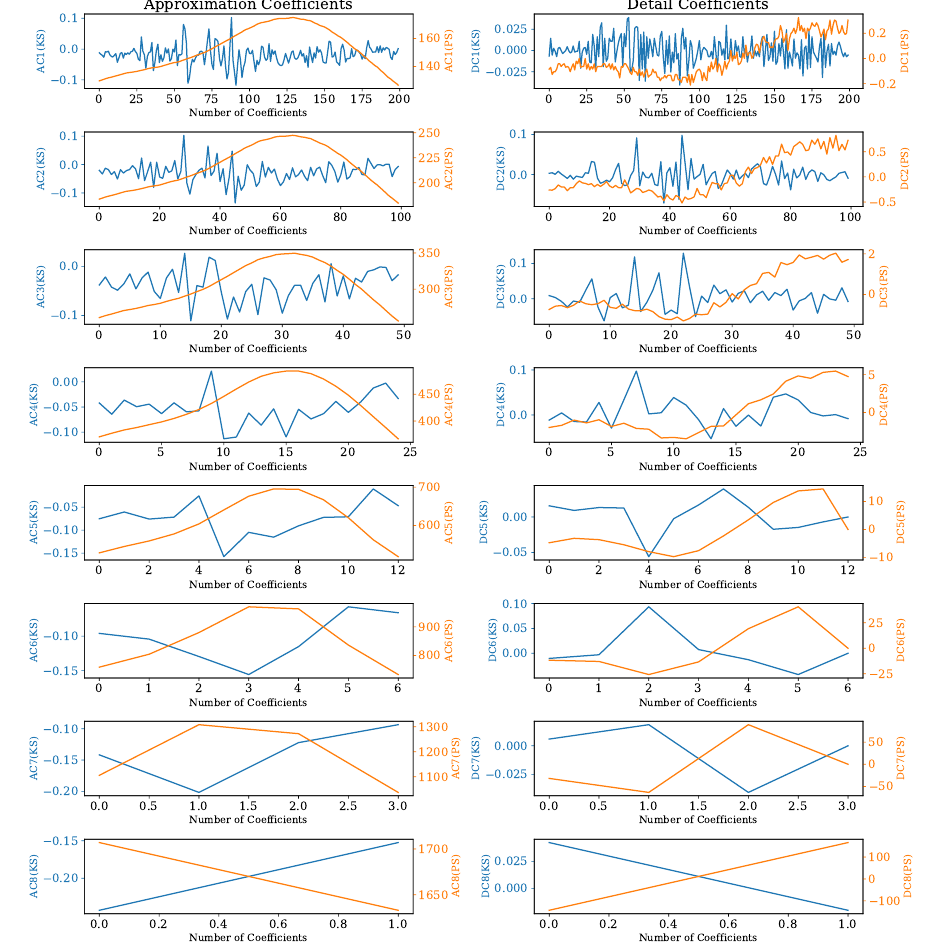
Figure 9. Resulting AC and DC from DWT of signals window.